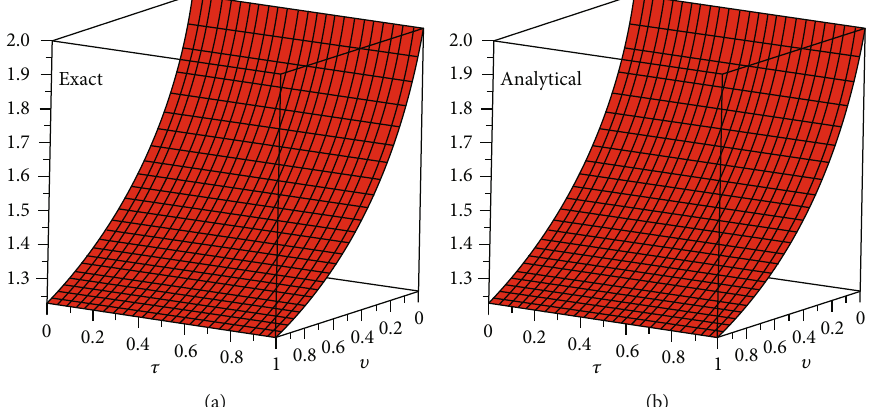
Figure 1: The graphical layout of the exact solution, proposed method solution at ρ = 1 and at various fractional orders of ρ = 1,0 : 8,0 : 6,0 : 4 with a , b = 1 for problem